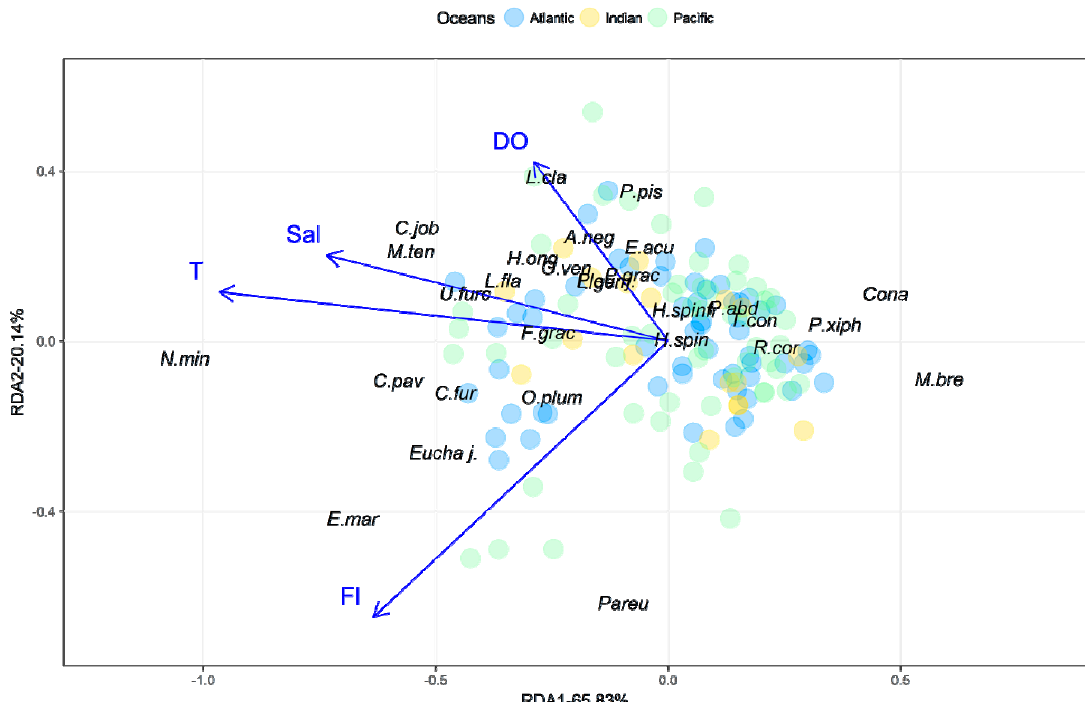
Figure 8. RDA of most dominant copepods and their environmental variables (Temperature-T, Fluorescence-Fl, Salinity-Sal, and Dissolved Oxygen-DO) in the whole study area. The first two canonical axes account with 85.97% of the variance explained. Dots indicate sampling stations at the di ff erent oceans, and they are ordered based on their environmental conditions. Nannocalanus minor ( N.min ), Euchaeta marina ( E.mar ), E. acuta ( E acu ), Euchaeta juveniles ( Eucha j.), Calocalanus pavo ( C. pav ), Clausocalanus jobei ( C.job ), C. furcatus ( C . fur ), Mesocalanus tenuicornis ( M.ten ), Urocycaeus furcifer ( U.furc), Lucicutia flavicornis ( L.fla ). L. clausi ( L.cla), Farranula gracilis ( F.gra ), Oithona plumifera ( O. plum ), Oncaea venusta ( O. ven ), Triconia conifera ( T.conif ), Haloptilus ornatus ( H. orn ), H. longicornis ( H . long ), Acartia negligens ( A.neg ), Pleuromamma abdominalis ( P.abd ), P. gracilis ( P.grac ), P. xipias ( P. xiph ), P. piseki ( P.pis ), Pleuromamma juveniles ( Pleuro j.), Heterorhabdus spinifer ( H.spin ), H. spinifrons ( H. spinf ), Rhincalanus cornutus ( R.cor ), Pareucalanus ( Pareu ), Conaea ( Cona ), and Metridia brevicauda ( M. bre ).